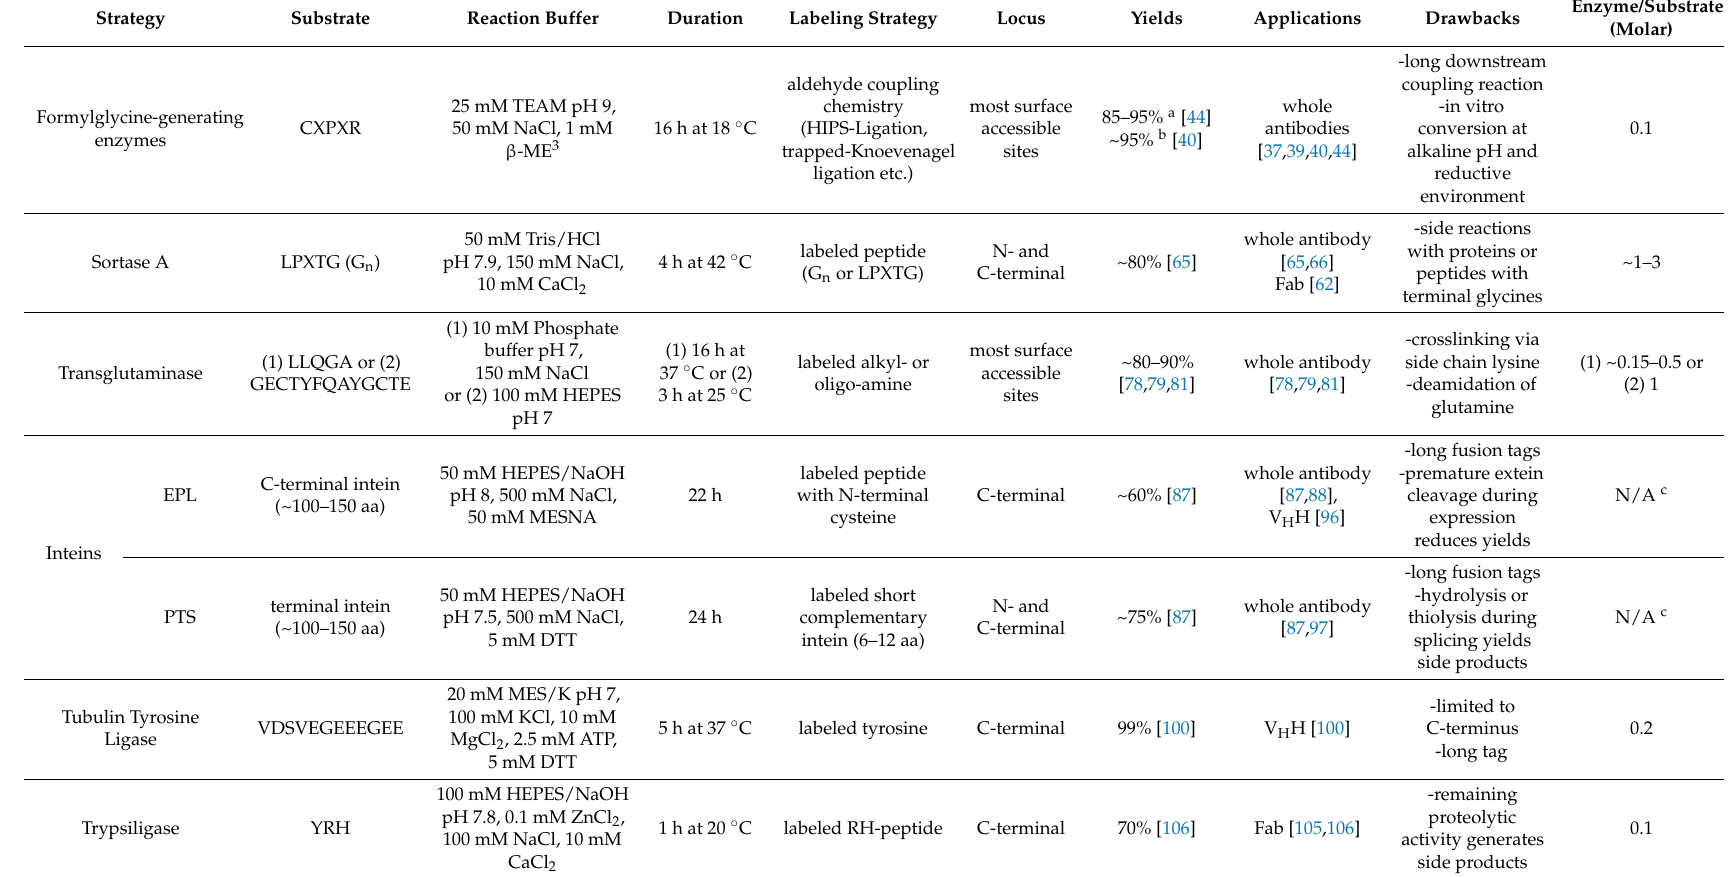
Table 1. Overview of enzyme-based labeling strategies including substrate motif, reaction conditions, chemical strategy, site of modification, conversion yields with antibody or antibody mimetic substrates, drawbacks, and enzyme to substrate